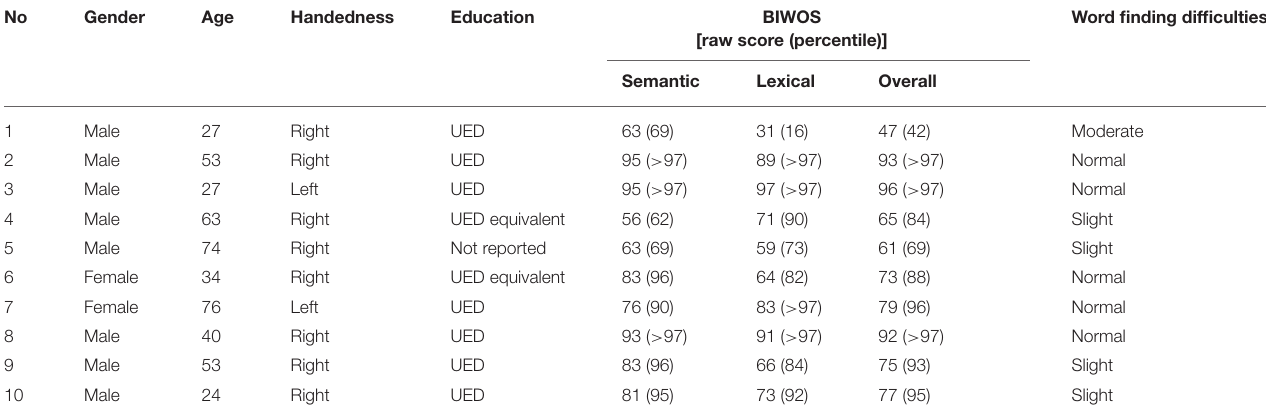
TABLE 4 | Patient